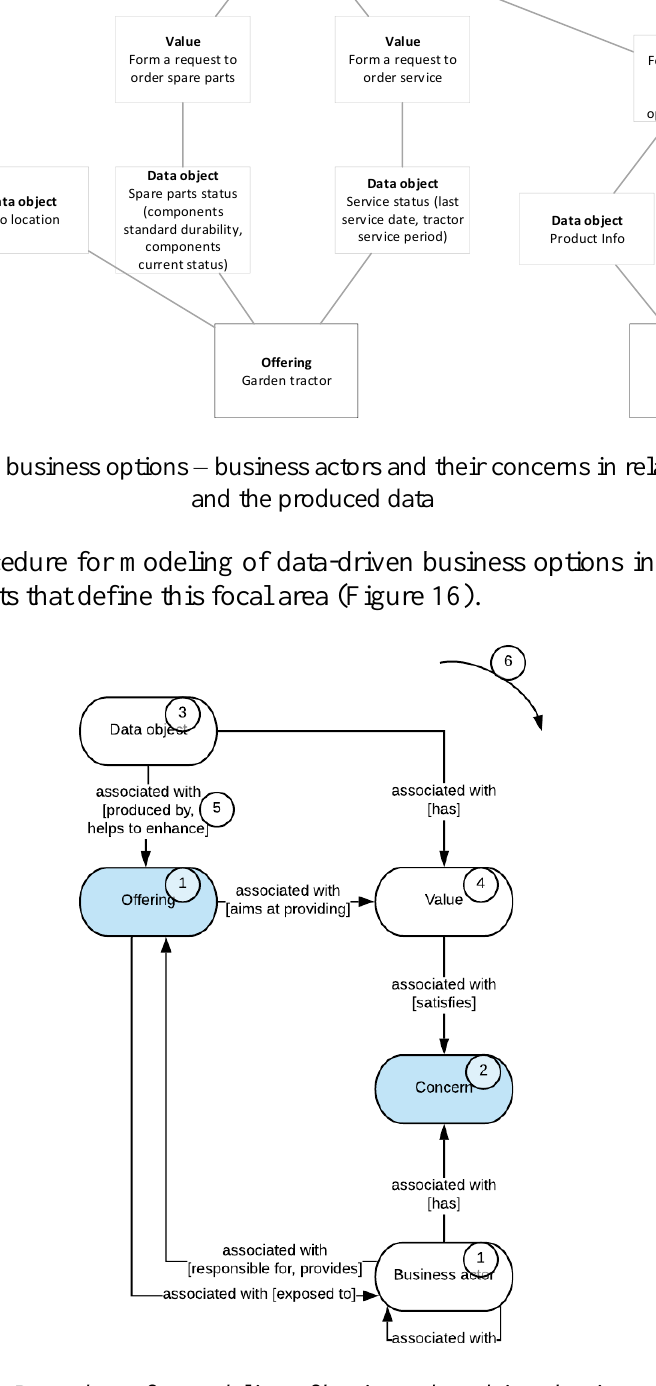
Figure 16. Procedures for modeling of business data-driven business